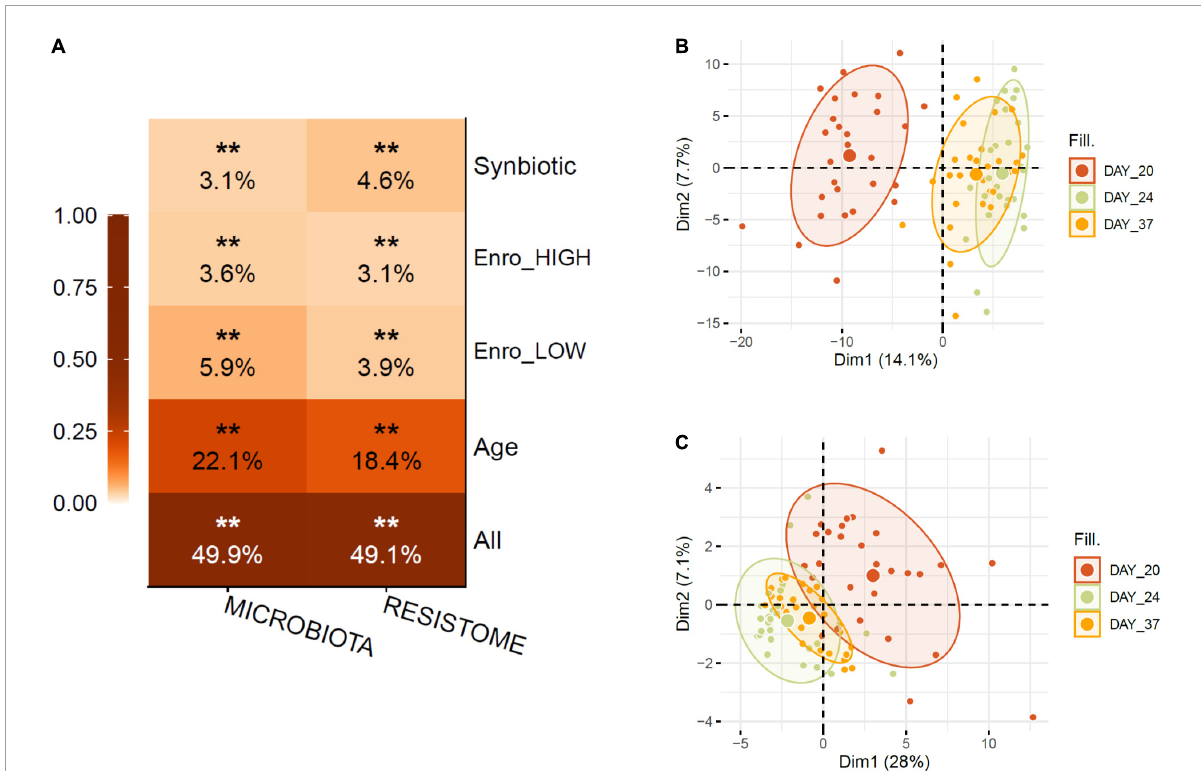
FIGURE2 (A) PERMANOVA shows that the animal age had the largest effect on variation for both measurement types followed by the low/optimized dosage of enrofloxacin application. Stratified tests (Enro-HIGH/OPT (LOW), Synbiotic) consider only samples within the indicated category. Stars show FDR-corrected statistical significance (FDR ** P ≤ 0.01). Variance is estimated for each feature independently, except for “All,” for which all metadata are included in the model. (B) Principle component analysis showing the changes in taxonomical and (C) ARG resistome profiles due to the effect of age. Ellipses indicate 95% confidence intervals of around centroids of the groupings with treatments as